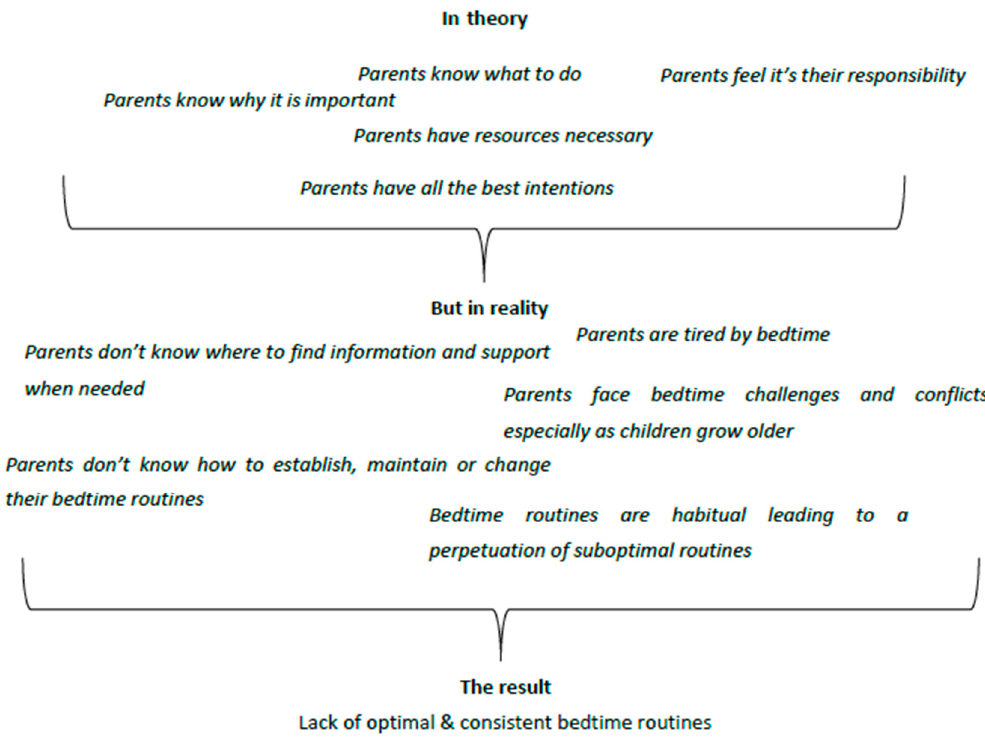
Figure 1. Schematic representation of key barriers and facilitators based on TDF. Flowchart presenting key barriers and facilitators identified by the study leading to the creation of sub-optimal bedtime routines.